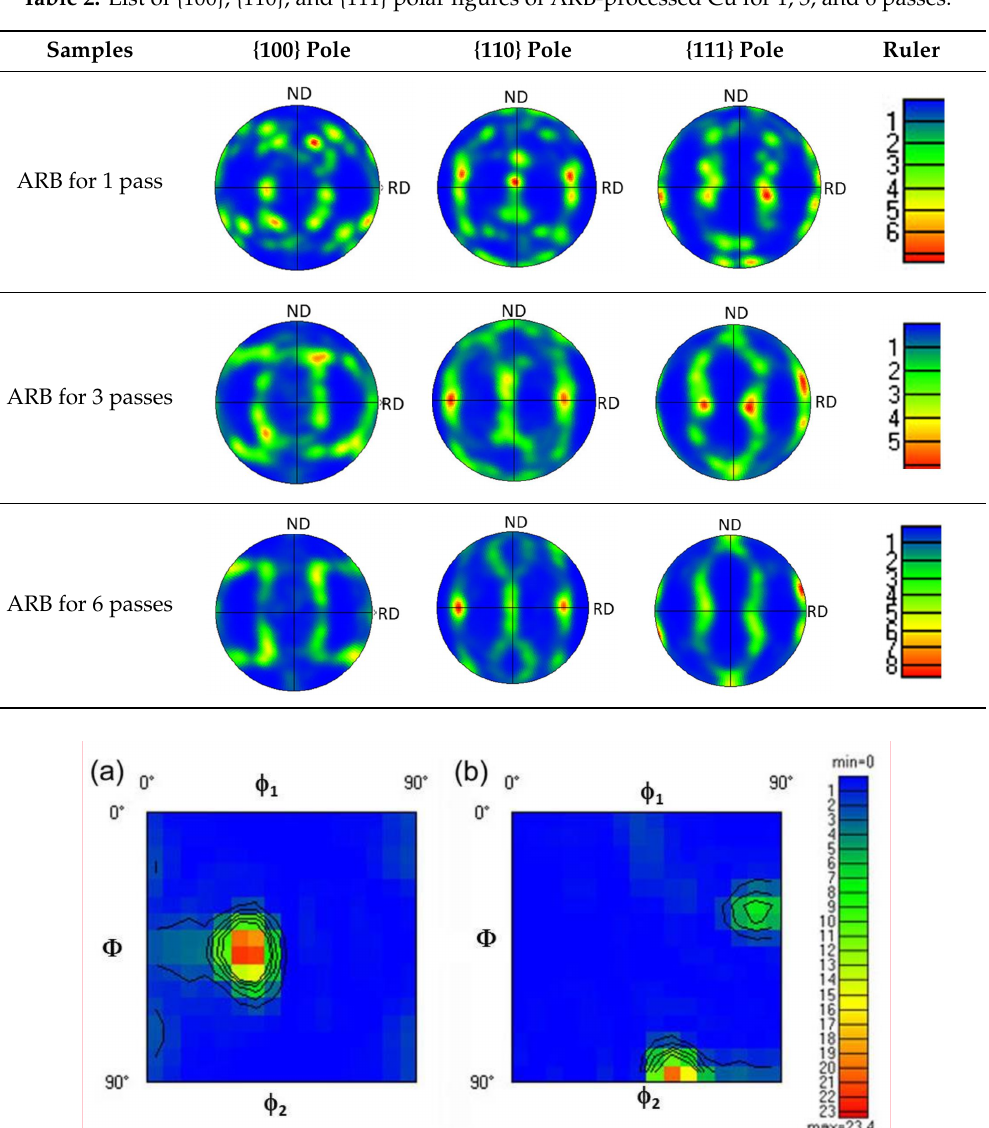
Figure 4. Orientation distribution function (ODF) of ARB-processed Cu for 6 passes when ϕ 2 is 0 ◦ ( a ) and 45 ◦ ( b